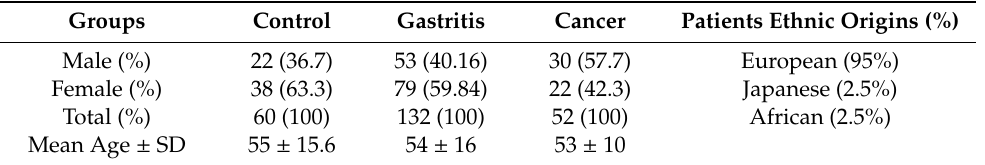
Table 1. Patient and group